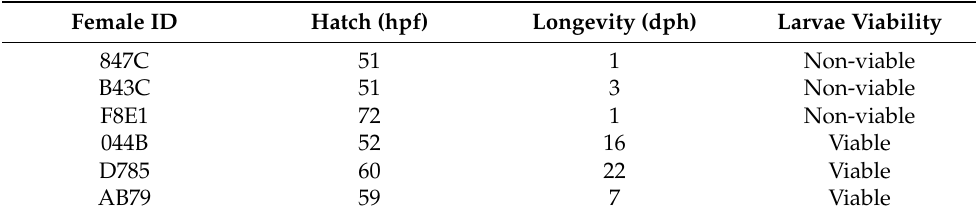
Table 1. Non-viable and viable larvae used for RNA-Seq analysis. Hatching time was expressed in hours post fertilization (hpf). Larvae viability was estimated by larvae longevity in days post-hatch (dph) to classify non-viable and viable larvae used for RNA-Seq. Female ID Hatch (hpf) Longevity